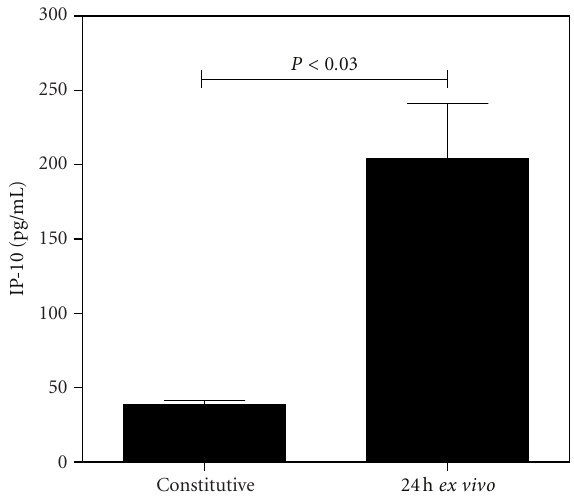
Figure 4: Cells resident in the cornea have the potential to produce IP-10. Corneas ( n = 4) were excised from uninfected mice and placed in 250 μ L of serum-free medium. Corneas were either pro- cessed immediately for analysis of chemokine production (consti- tutive levels) or incubated at 37 ◦ C in 5% CO 2 for 24h. Chemokine levels were quantitated by ELISA and reported as pg/mL of sample.